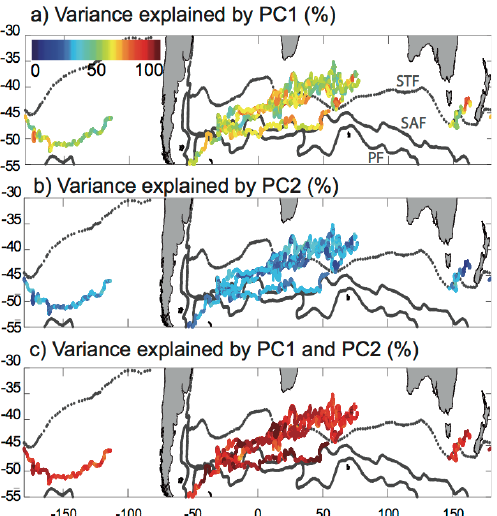
Fig. 5. Variance explained by (a) the first principal component (PC1), (b) the second principal component (PC2); (c) the cumu- lated variance explained by PC1 and PC2 obtained with the local PCA for DIC, SST and fluorescence.